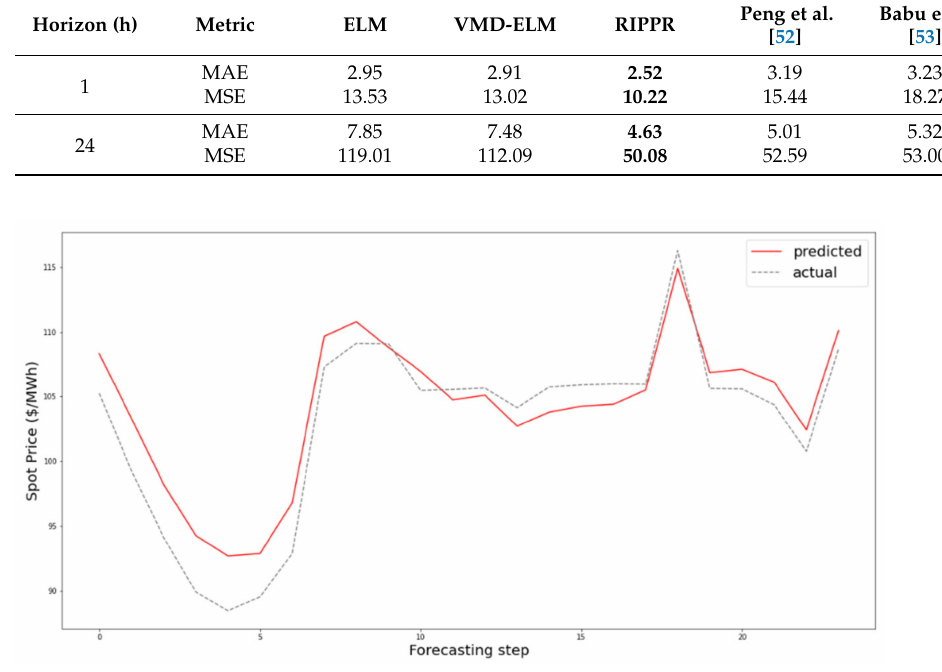
Figure 9. Forecasting performance of RIPPR for one hour